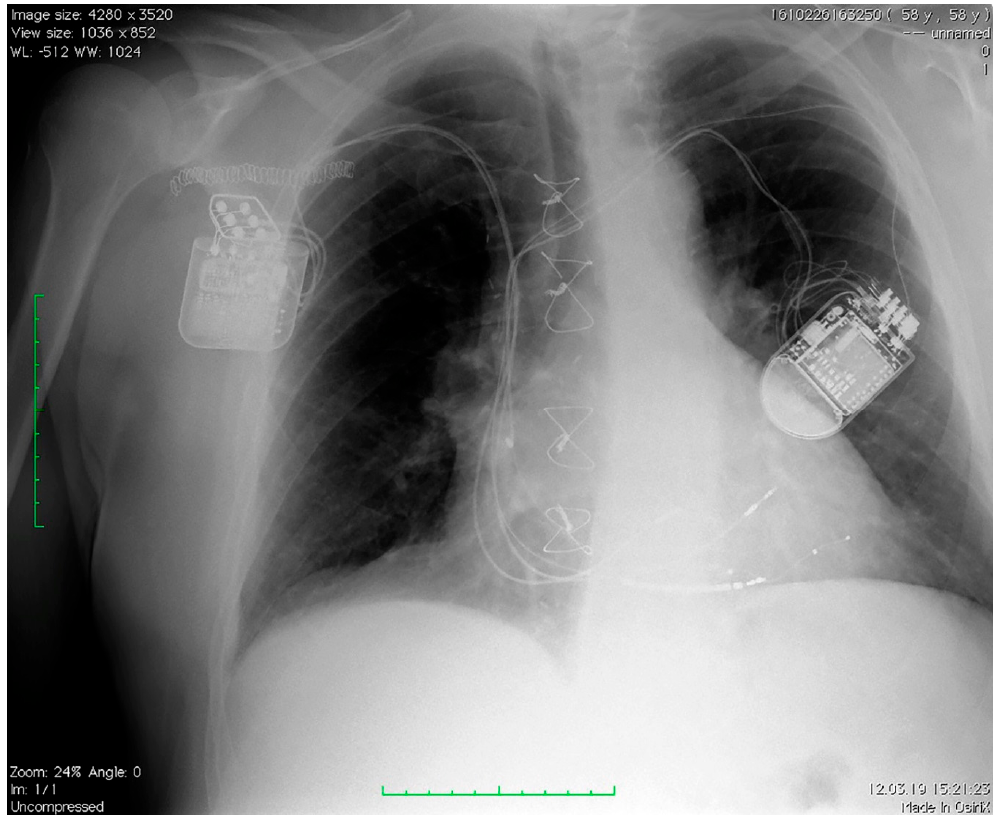
Figure 1. Chest X-ray of a patient with a CRT device on the left side and a CCM device on the right side of the thorax. CRT: cardiac resynchronization therapy; CCM: cardiac contractility modulation.